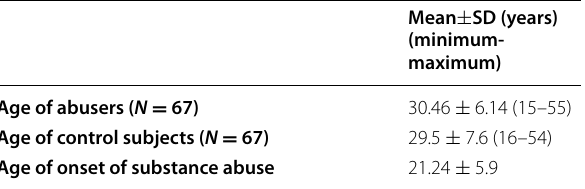
Table 1 The mean age of tramadol abusers and control subjects and mean ages for onset of abuse